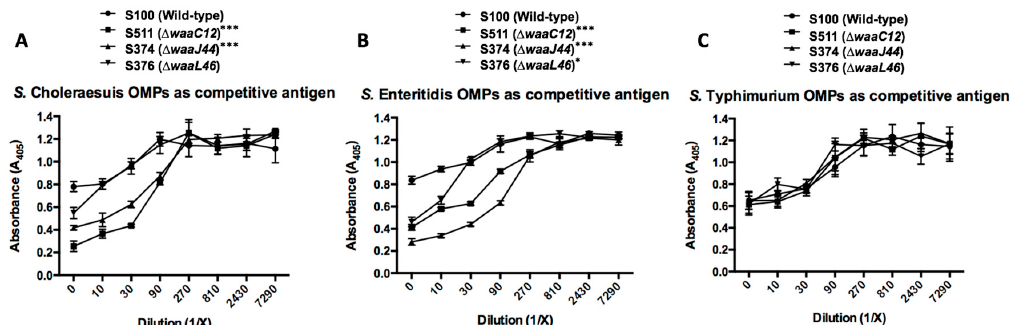
Figure 6. Competitive ELISA to confirm the cross-reactivity of OMPs from the truncated LPS mutants against heterologous Salmonella . OMPs isolated from S. Typhimurium were incubated in the plate as the coating antigen. OMPs from S. Choleraesuis ( A ) or S. Enteritidis ( B ) as the competitive antigen and OMPs from S. Typhimurium ( C ) as the control competitive antigen diluted from 1/10 to 1/7290 (Dilution, 1/X) were incubated in wells. The sera were obtained from mice ( n = 8) immunized with OMPs from the parent strain and its mutants at eight weeks after the primary immunization. The error bars represent variations from triplicate wells. *** p < 0.001; * p < 0.05; compared to titers from mice immunized with OMPs from the parent strain S100.